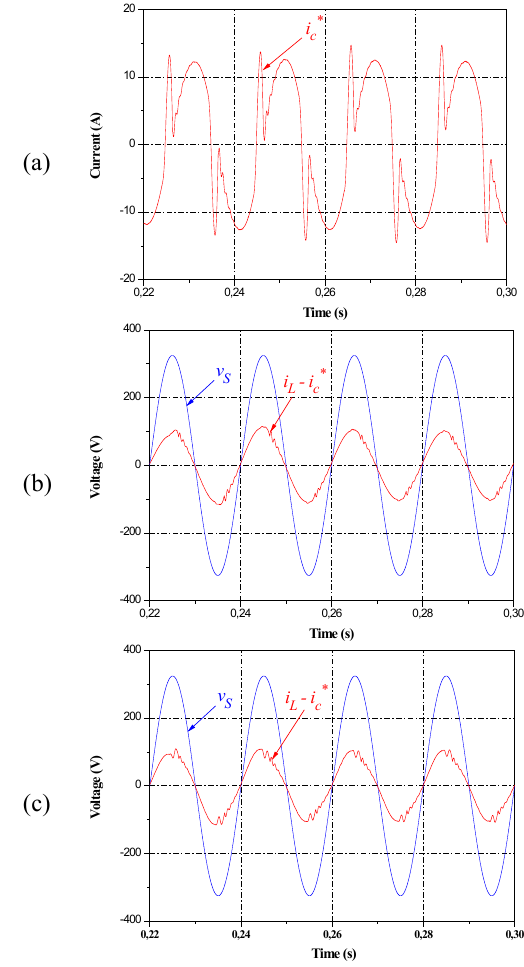
Figure 7. Simulation results: (a) Reference compensation current produced by the Fryze theory, (b) Theoretical source current after compensation for the conventional SAPF; (c) Theoretical source current after compensation for the proposed SAPF with reduced dc-link.